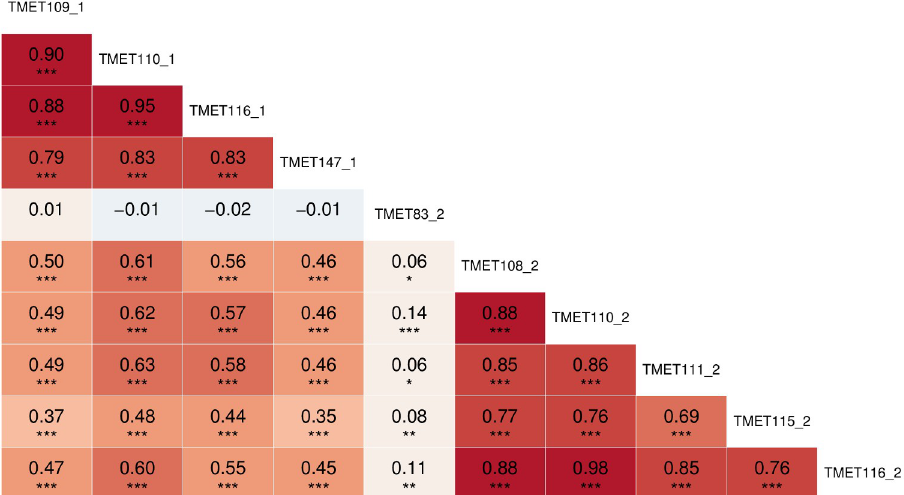
Fig 1. Pearson’s correlation coefficients of metabolites investigated in this study. Significant correlation coefficients are indicated with � p < 0.05, �� p < 0.01 and ��� p < 0.0001. The colour intensity indicates the strength of the correlation. Red indicates positive, blue indicates negative correlation. Metabolites from the first and second sampling date are highly correlated among themselves, with the exception of TMET83_2. The correlations between the first and second sample date are also medium positive and highly